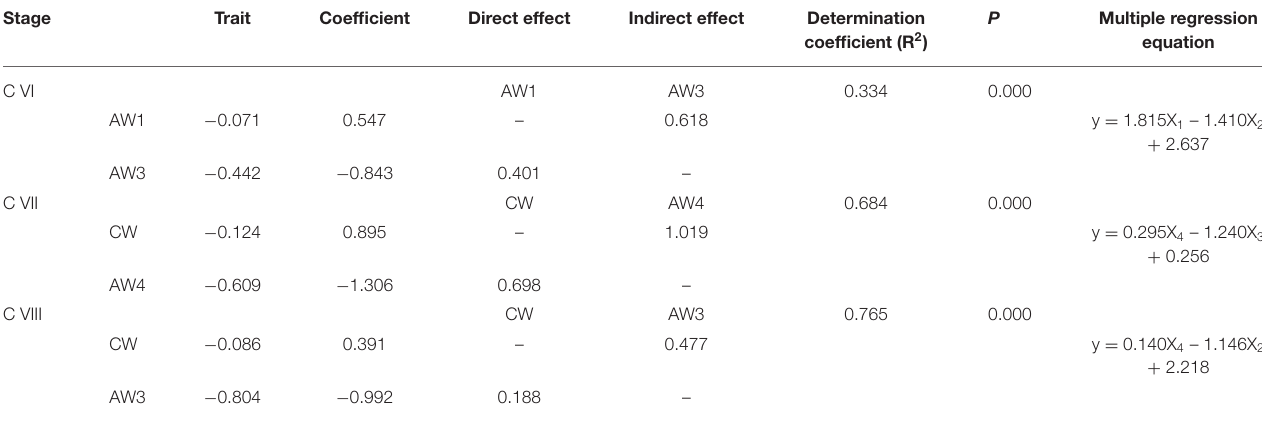
TABLE 4 | Multiple stepwise regression analysis between the morphological traits and sex at three developmental